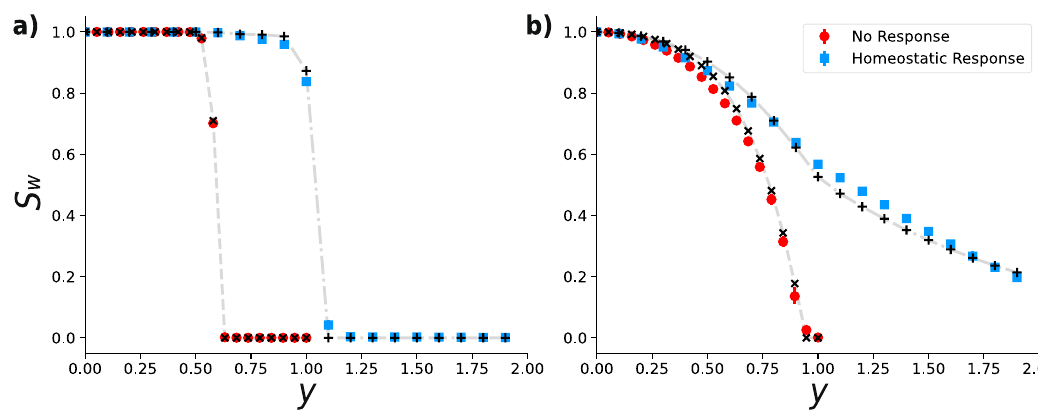
Fig. 3 Homeostatic response delays the disruption of the giant component. Evolution of the weak giant component ’ s size, S W , as a function of the threshold y , for a a regular random graph of N = 2 × 10 4 nodes and degree z = 4 with Gaussian distributed weights (the same distribution of Fig. 2), and b a brain network of N = 983 nodes representing a volume of the mouse neocortex 31, 32 with uniformly distributed weights in the interval [0,1]. Colored markers represent the outcome of Monte Carlo simulations, obtained by averaging over 100 realizations of the weight distribution for the regular graph, and 1000 realizations for the real dataset. In both cases, we considered 20 successive steps of fi ltration without response (red circles) and with the homeostatic response (blue squares). Black markers represent the corresponding estimates from the model for each value of y , while gray dashed and dash-dotted lines represent linear interpolations between theoretical values, which serve only as visual nodes are path-connected regardless of the direction of the links — the largest weakly connected component. We estimate the size